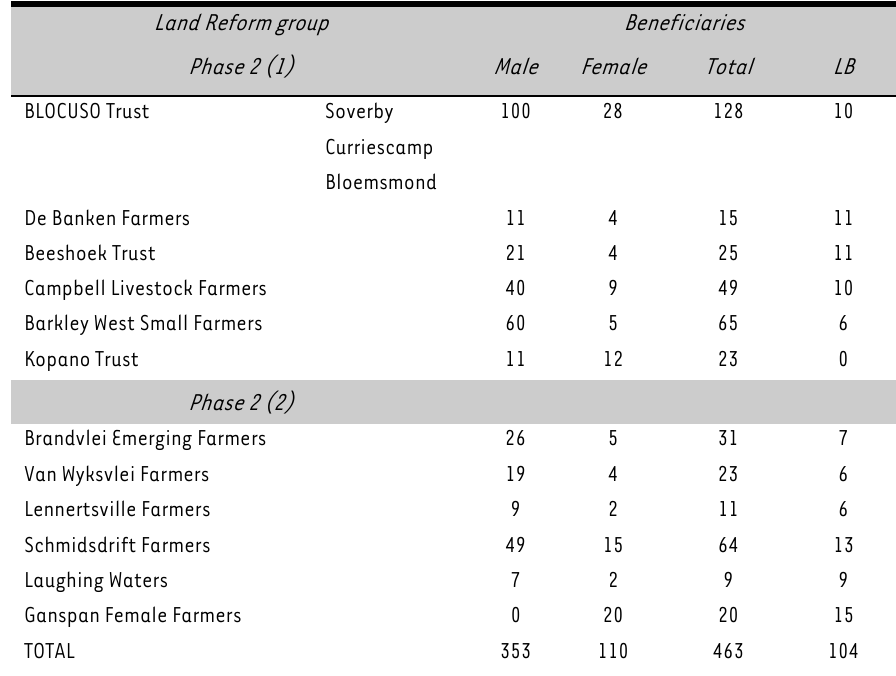
TABLE 1: Number of beneficiaries by gender,